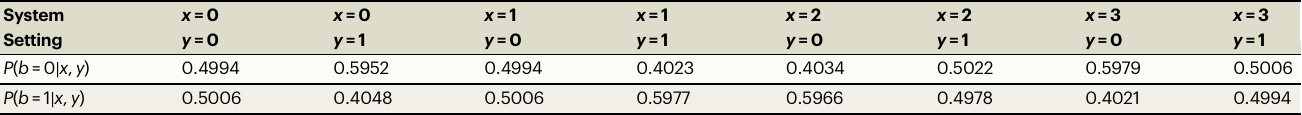
Table 4 | Observed experimental results for the test rounds